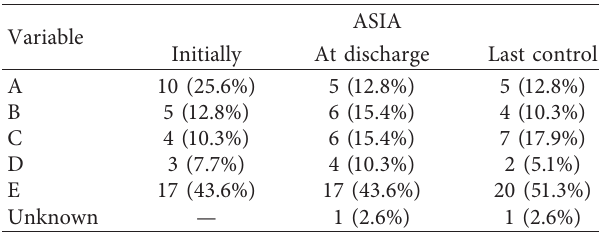
Figure 4: Plain radiograph obtained after surgical repair of cervical injury by a combined anterior and posterior approach. Table 1: The features of spinal cord injury at the cervical region due to dive or fall into shallow water.